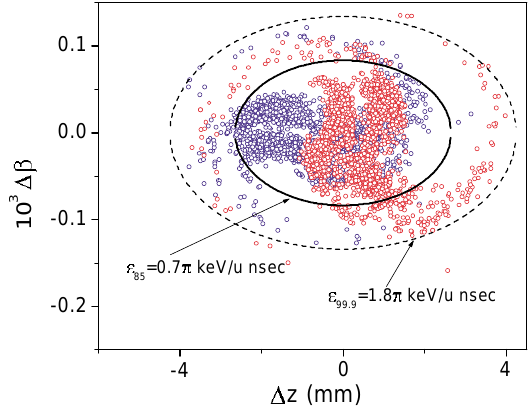
FIG. 6. (Color) Longitudinal phase space plots of particles ex- iting the RFQ.